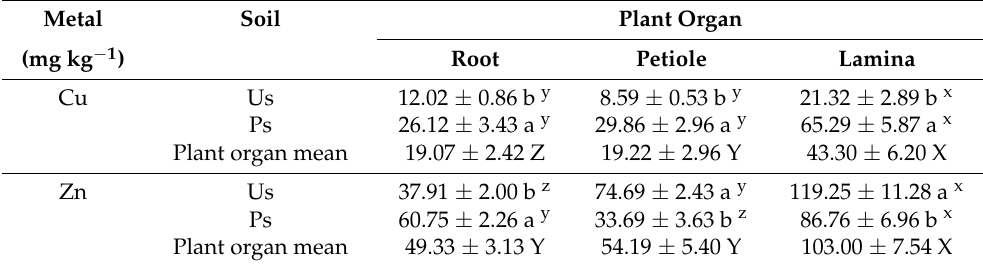
Table 3. Cu and Zn concentrations in different organs of S. perfoliatum plants grown in heavy metal Ps and Us. Metal Soil Plant